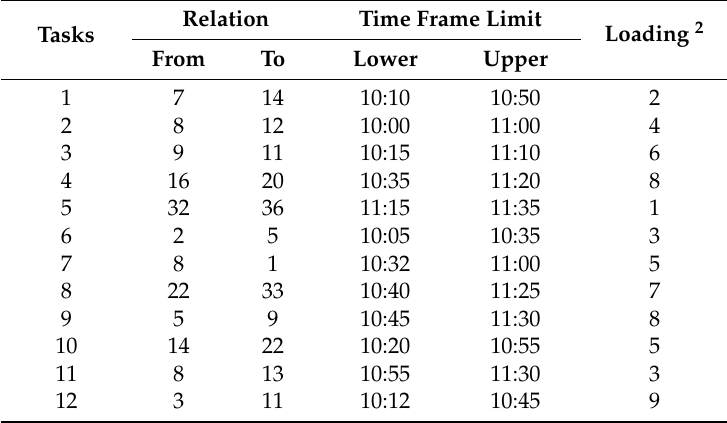
Table 2. Input parameters of the clustering problem 1 .